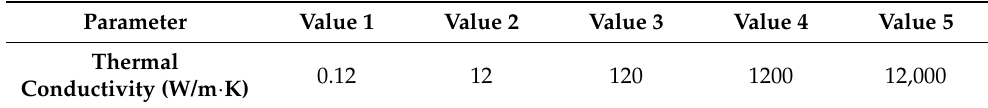
Table 4. Thermal conductivity values for the performed test.